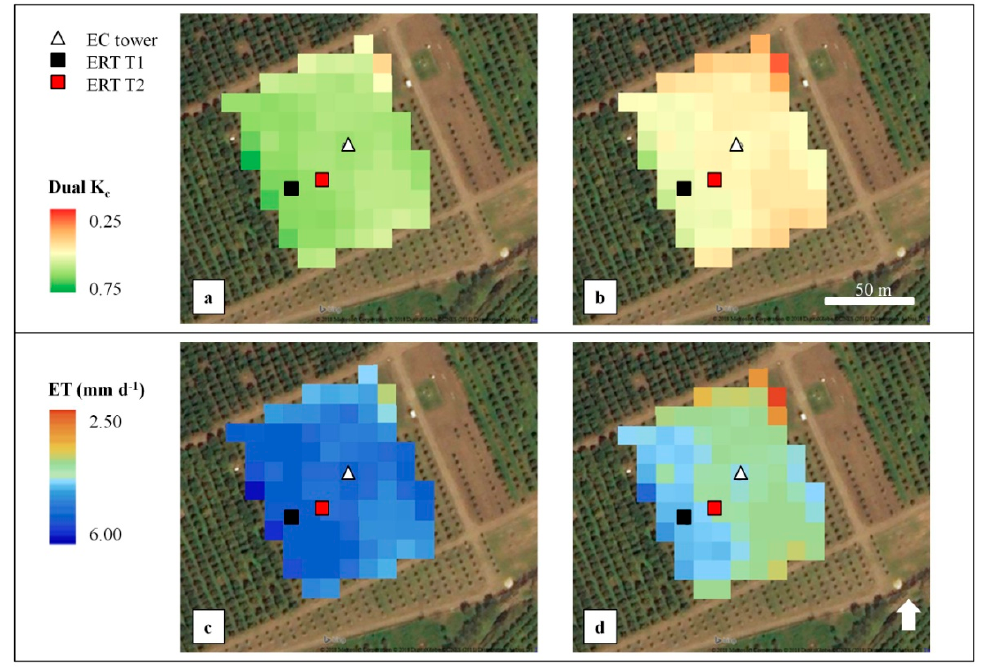
Figure 7. Dual crop coefficient (K c,FAO and K c,ERT ; a , b ) and ET (ET FAO and ET ERT ; c , d ) estimates obtained by the original and ERT-adjusted dual K c FAO-56 approach for DOY 193 (under ET 0 conditions of 8.56 mm day − 1 ).